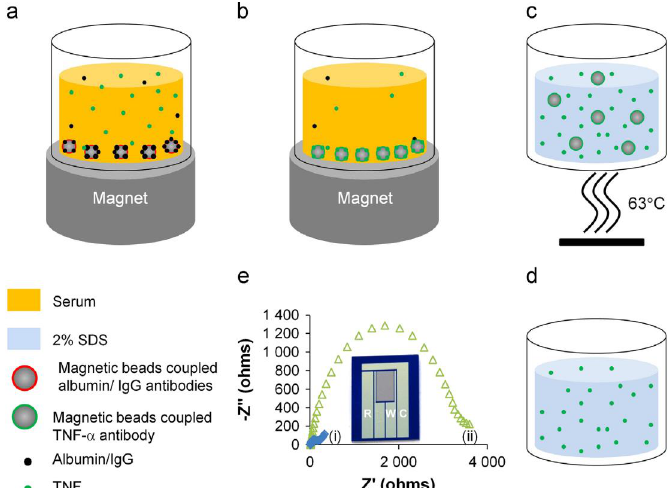
Figure 13. Schematic illustration of a magnetoimmunosensor for TNFα detection ( a ) Serum back- ground is removed using magnetic beads coated with albumin and IgG antibodies. ( b ) The back- ground removed sample is transferred to a new tube, and TNFα is then captured using magnetic bead coated with TNFα antibody. ( c ) The captured TNFα is eluted from the magnetic beads using 2% SDS at 63 ℃, and ( d ) the magnetic beads are separated out of the eluted sample. ( e ) Impedance spectra of the eluted sample are then analyzed using an EIS technique in which the CSGM elec- trode is employed as a platform for TNFα adsorption and for EIS analysis. R, W and C labeled on CSGM electrodes denote reference, working and counter electrodes, respectively. Nyquist plots represent impedance spectra recorded from (i) blank chip and (ii) eluted sample of 1pg/ml TNFα spiked in human serum. Reprinted from [99] with permission from Elsevier.